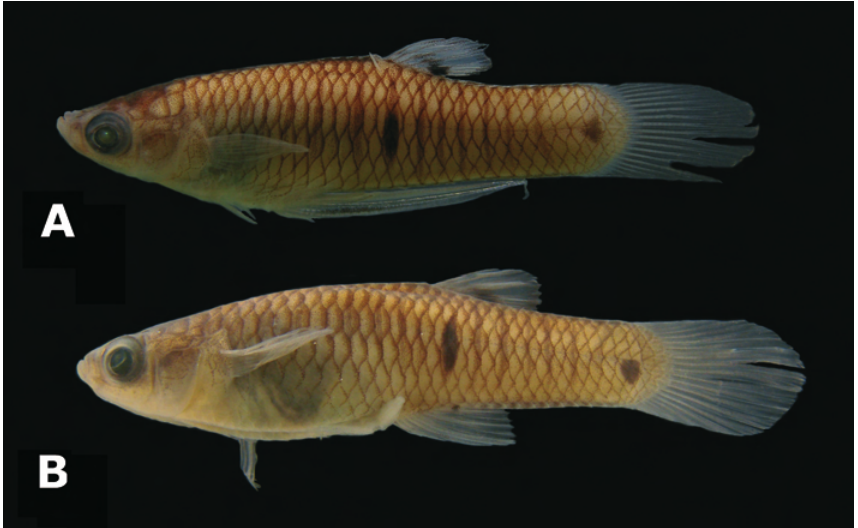
Fig. 48. Phalloceros spiloura . (A) Holotype, male, 22.0 mm SL, MCP 30401, creek ca . 200 m from arroio do Padre, Itati, Rio Grande do Sul, Brazil; (B) paratype, female, MCP 29270, 25.0 mm SL, collected with the